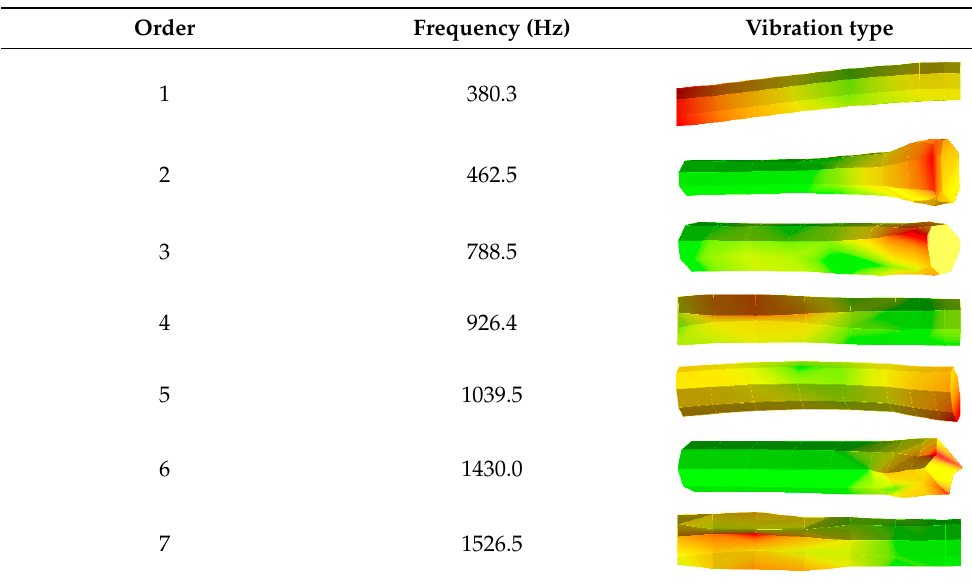
Table 1. Modal experimental equipment.